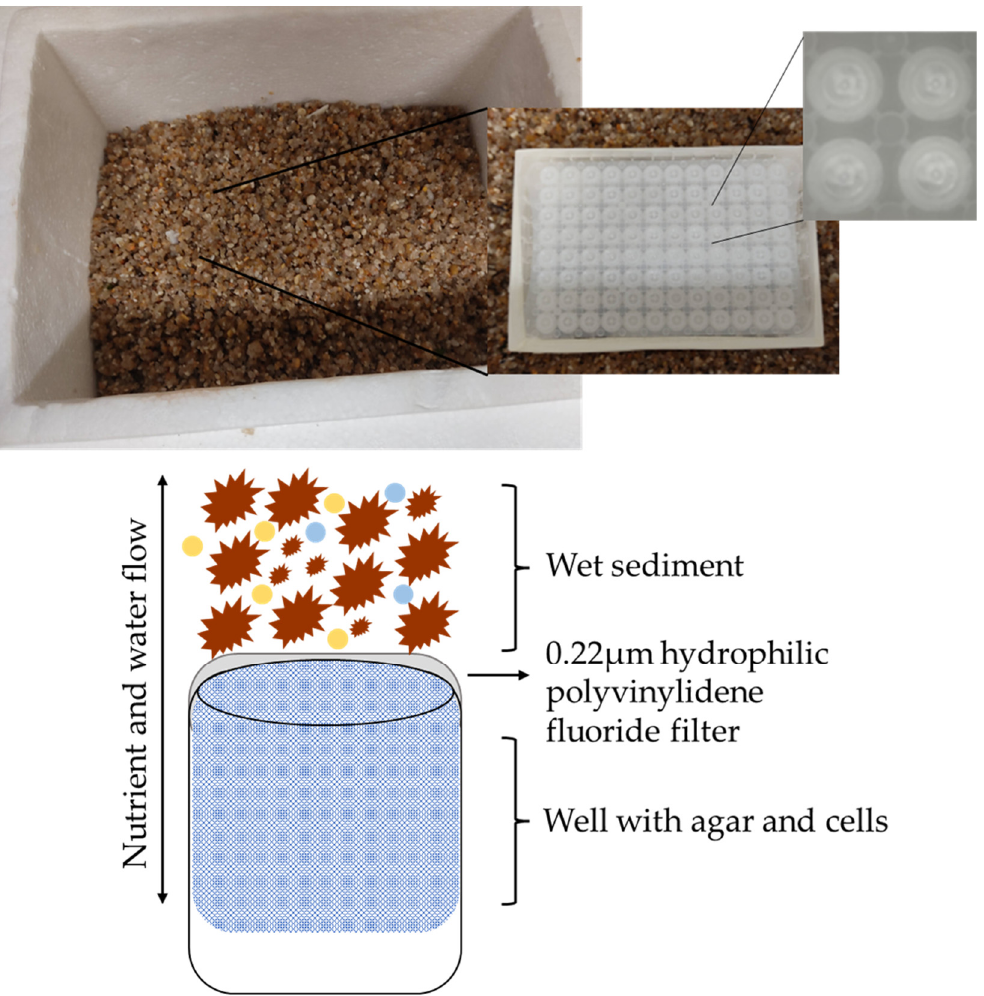
Figure 1. Scheme of the iChip methodology using the MultiScreen ® 96-Well Filtration Plate (Nunc, Roskilde, Denmark ) in a sediment box to simulate the natural environment. Roskilde, Denmark) in a sediment box to simulate the natural